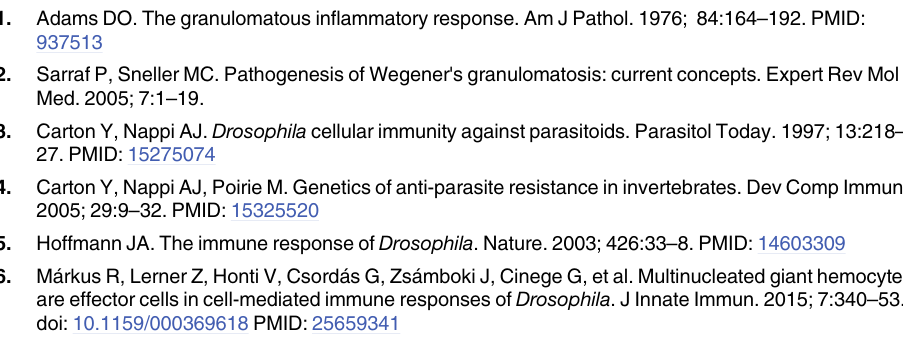
S5 Fig. The proportion of living, partially or completely encapsulated and melanized wasp larvae in raspberry RNAi silenced Drosophila larvae. Two independent RNAi lines were used driven by msnF9mo-Gal4 . The encapsulation efficiency was examined at 48h following the wasp infestation. The numbers in parenthesis indicate the number of the examined D . melano- gaster larvae. The error bars indicate the standard error of the mean. (cid:1)(cid:1) p < 0.01, (cid:1)(cid:1)(cid:1) p < 0.001. S6 Fig. The proportion of living, partially or completely encapsulated and melanized wasp larvae in raspberry RNAi silenced Drosophila larvae. Two independent RNAi lines were used driven by He-Gal4 . The encapsulation efficiency was examined at 48h following the wasp infes- tation. The numbers in parenthesis indicate the number of the examined D . melanogaster lar- vae. The error bars indicate the standard error of the mean. (cid:1) p < 0.05, (cid:1)(cid:1)(cid:1) p < 0.01, (cid:1)(cid:1)(cid:1) p < 0.001. S7 Fig. The proportion of living, partially or completely encapsulated and melanized wasp larvae in raspberry RNAi silenced Drosophila larvae. Two independent RNAi lines were used driven by He-Gal4 . The encapsulation efficiency was examined at 72h following the wasp infes- tation. The numbers in parenthesis indicate the number of the examined D . melanogaster lar- vae. The error bars indicate the standard error of the mean. (cid:1)(cid:1) p < 0.01, (cid:1)(cid:1)(cid:1) p < 0.001. S8 Fig. The proportion of melanized wasp eggs with tight or loose capsule structure in msnF9mo-Gal4/UAS-rasRNAi larvae. The numbers in parenthesis indicate the number of the examined partially or completely encapsulated and melanized wasp eggs at 72h following the immune induction. (cid:1)(cid:1) p <